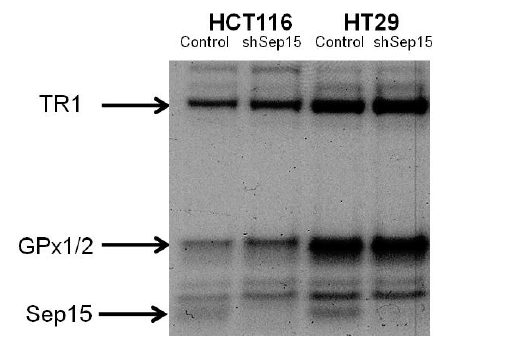
Figure 2. Protein expression of Sep15, GPx1/2 and TR1 upon targeted removal of Sep15 in HCT116 and HT29 human colorectal cancer cells, as determined by labeling cells with 75